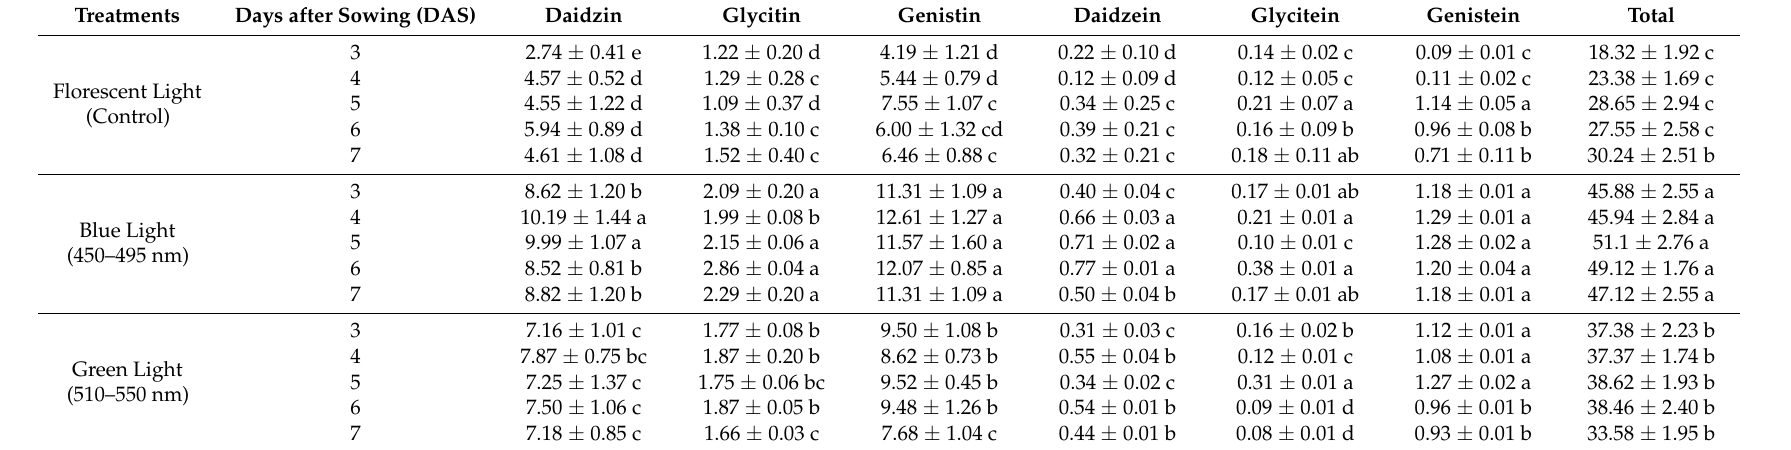
The values are mean ± standard deviation (SD). ( n = 3). Values labeled with different letters are significantly different ( p <